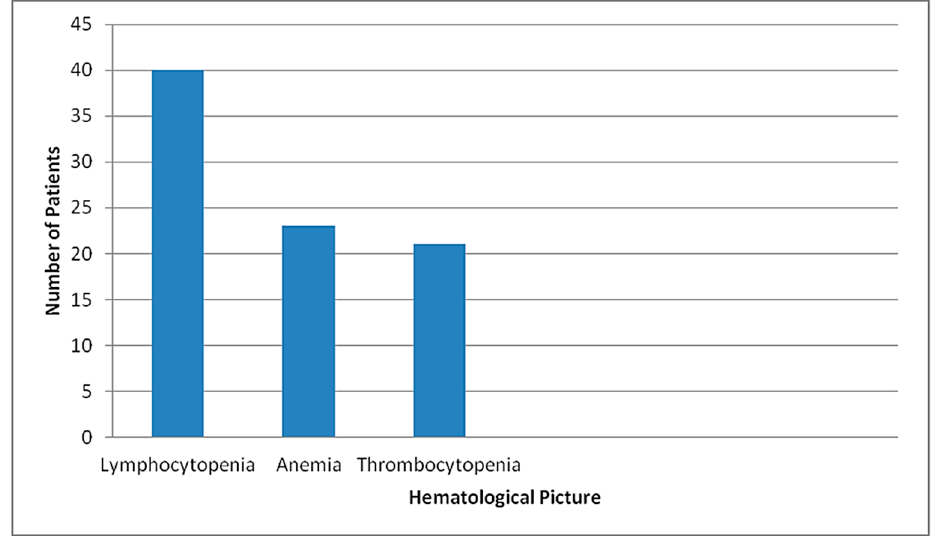
Figure 7. Distribution by hematological picture of the mortalities in STIDH (n =